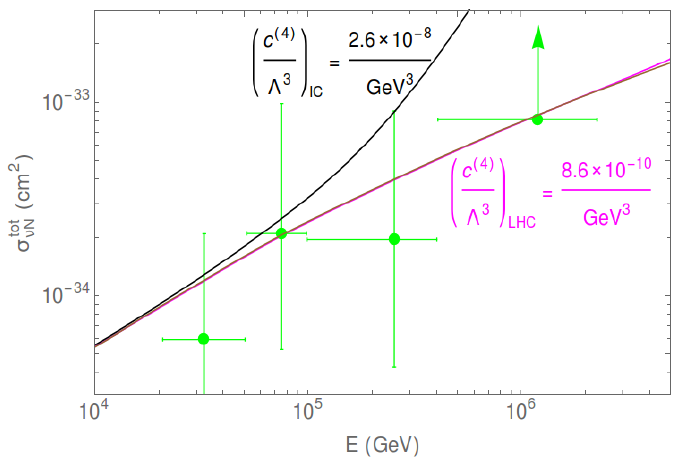
Figure 7 . Constraints on NSI appearing in eq. (4.7). Colour coding is the same as in (cid:12)gure 1. For the above interaction, the most relevant low-energy constraint comes from the mea- surement of neutrino-nucleon cross-section at CHARM, c (5) = (cid:3) 3 . 1 : 6 (cid:2) 10 (cid:0) 6 GeV (cid:0) 3 [53]. LHC monojet+ =E searches lead to the constraint, c (5) = (cid:3) 3 . 1 : 6 (cid:2) 10 (cid:0) 10 GeV (cid:0) 3 . T